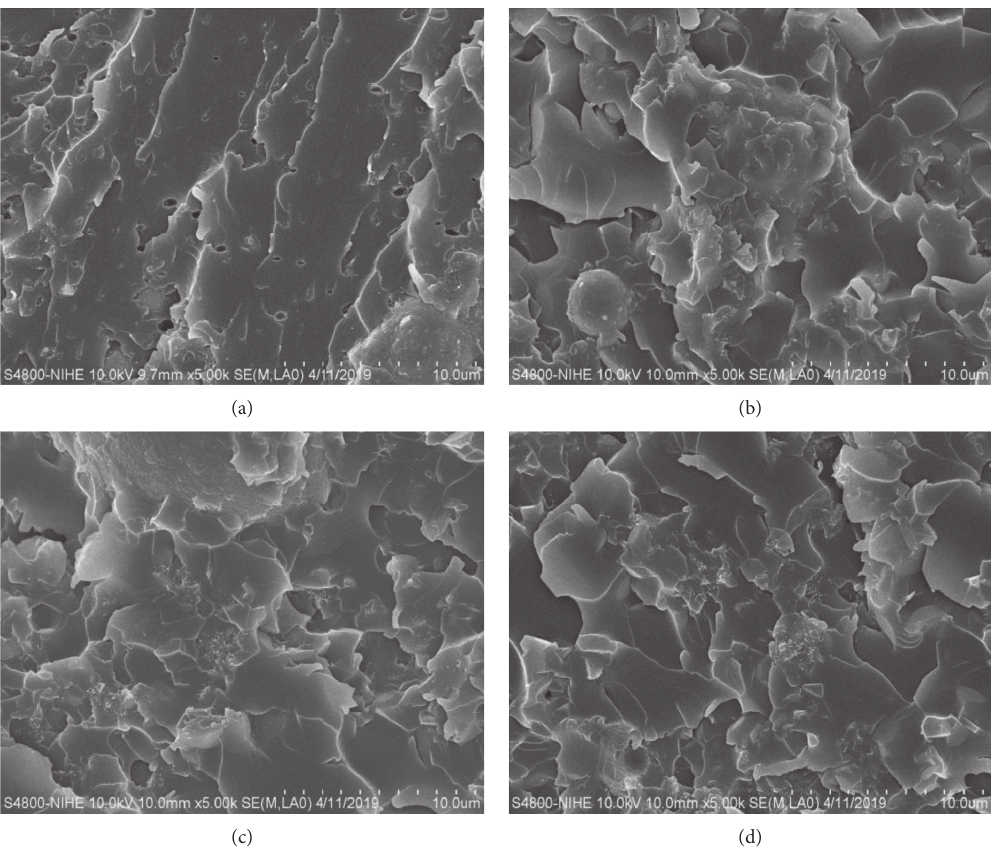
Figure 5: SEM images of nanocomposites fly ash/MWCNTs/epoxy: (a) 30 wt.% fly ash/0.03 wt.% MWCNTs/epoxy; (b) 40 wt.% fly ash/0.03 wt.% MWCNTs/epoxy; (c) 40 wt.% fly ash/0.04 wt.% MWCNTs/epoxy; and (d) 40 wt.% fly ash/0.05 wt.%